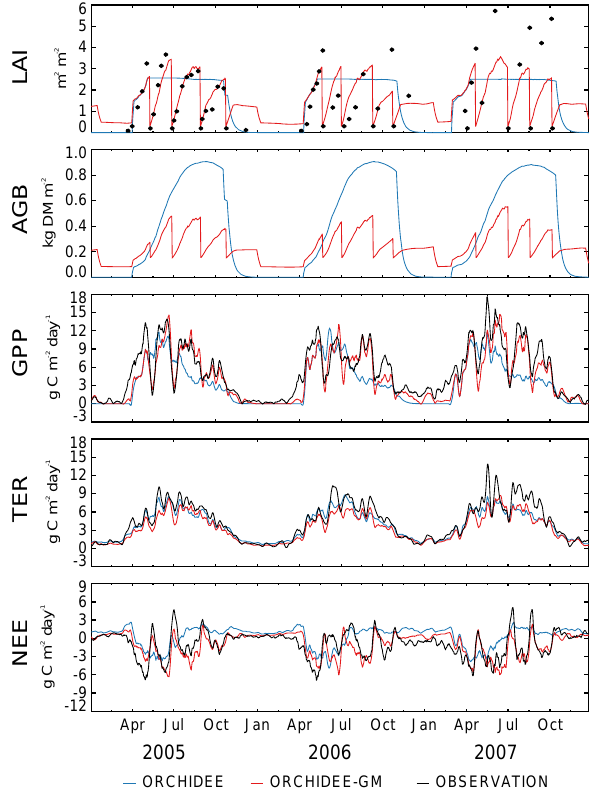
Fig. 4. Comparison of simulated/observed biometric variables and Figure 4 1030 carbon fluxes for the cut grassland of Oensingen, CH-Oe1. LAI, leaf area index; AGB, aboveground biomass (dry matter); GPP, gross primary production; TER, terrestrial ecosystem respiration; NEE, net ecosystem exchange. GPP, TER and NEE are presented as 15 day running means to smooth out very high